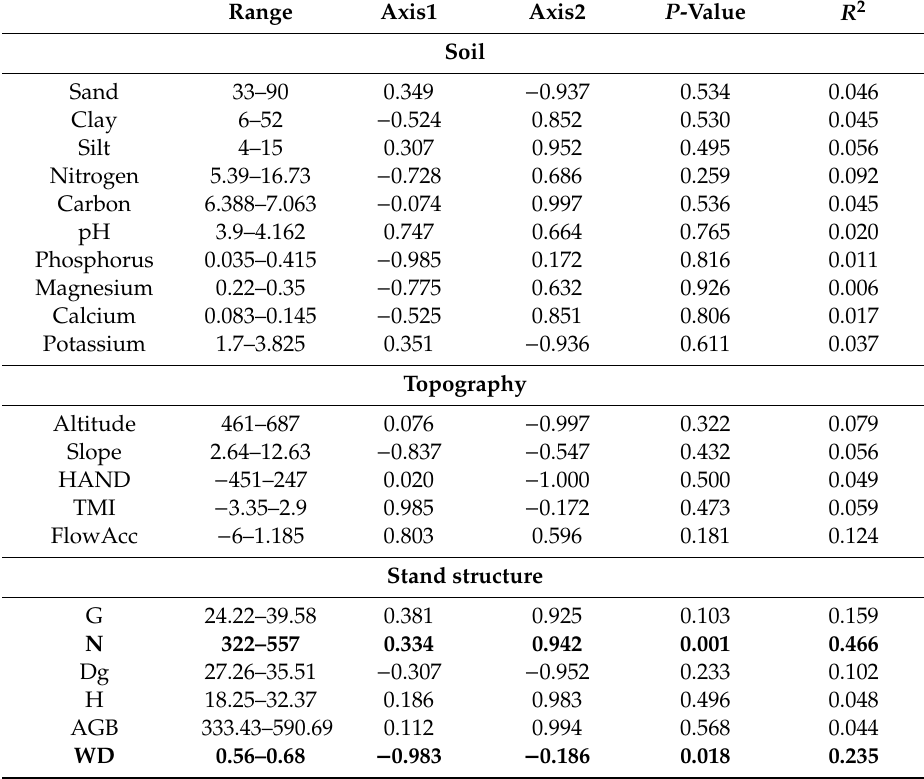
Table 1. Correlation between the first two non-symmetric correspondence analysis (NSCA) axes of species composition and soil, topographic variables and stand structure variables. Significance ( P -value) provided by a permutation test (999 permutations) and bold-faced characters indicate statistically significant correlation at P < 0.05. HAND: height above nearest drainage; TMI: topographic moisture index; FlowAcc: flow accumulation; G: tree basal area; N: stem density; Dg: quadratic mean